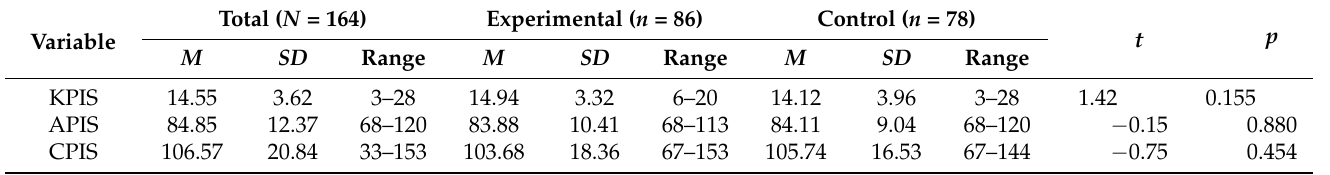
Table 2. Baseline score on KPIS, APIS, and CPIS in the experimental and control